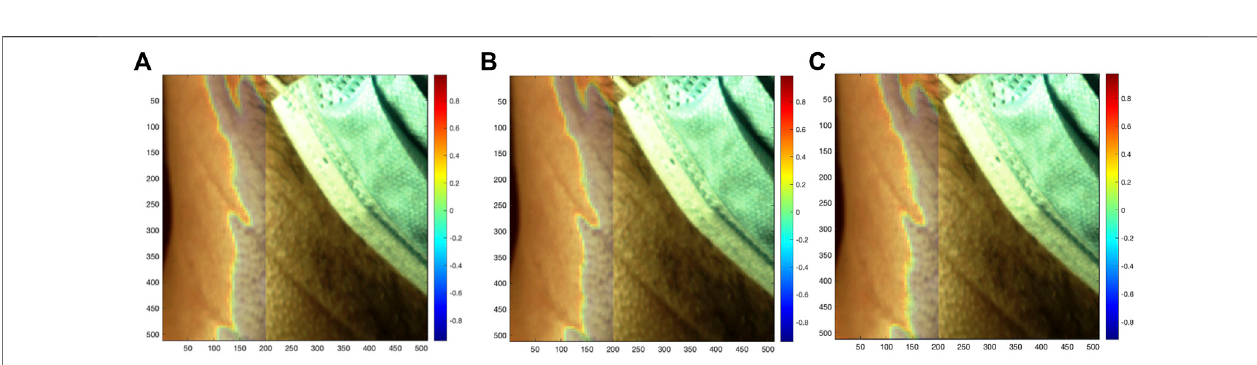
FIGURE 5 | Correlation of each local SRVI (red (A) , green (B) , and blue (C) channels, respectively) to the global SRVI extracted from the ROI (value of Pearson correlation coef fi cient shown using coloring), overlaid as a transparent map on the fi rst video